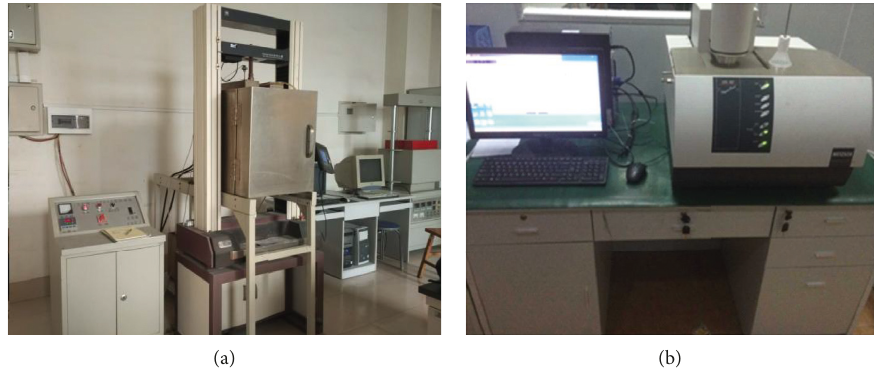
Figure 1: Photos of the test equipment: (a) WKM-2200 three-point bend testing device and (b) LFA-427 laser thermal conductivity meter.